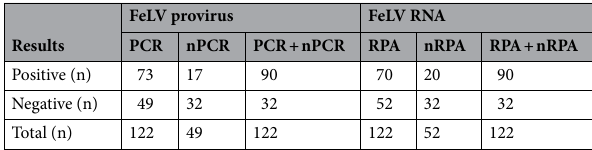
Table 1. Testing of clinical samples by PCR, nPCR, RPA, and nested